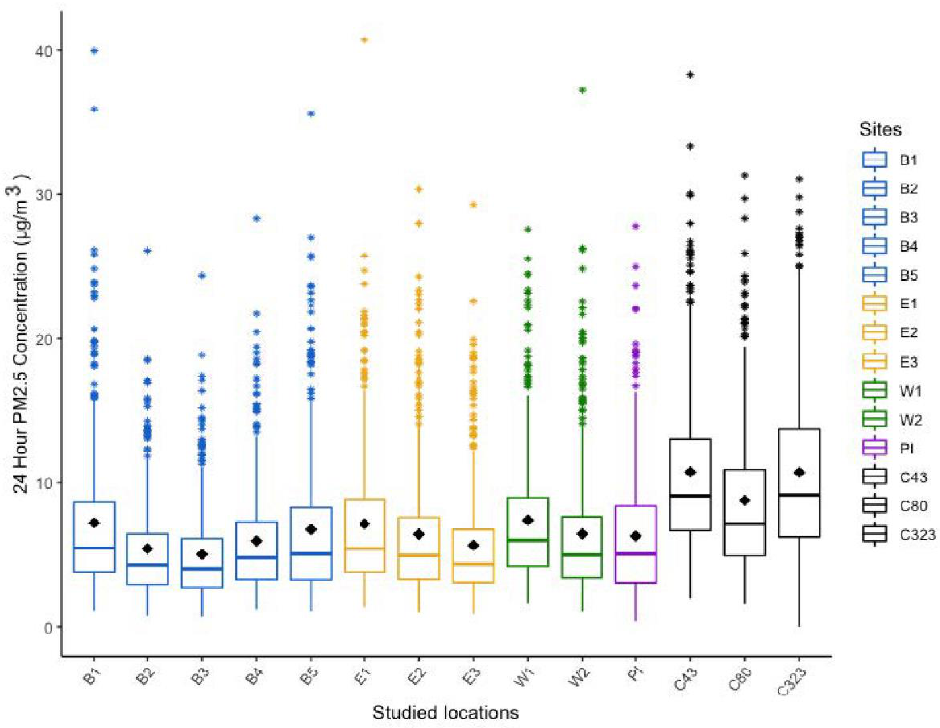
Figure 4. Boxplot of 24 h PM 2.5 concentrations ( µ g/m 3 ) from the LCSs and TCEQ CAMSs. Asterisks correspond to outliers and diamond corresponds to the mean. Table 4. Descriptive statistics for 24 h PM 2.5 concentrations (μg /m 3 ) in the studied sites.